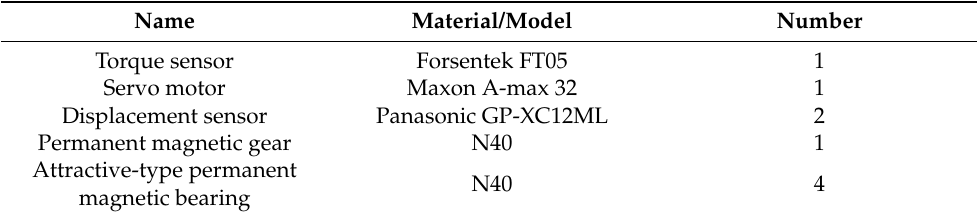
Figure 2. Physical structure of the noncontact torsion testing device: ( a ) Overall structure ( b ) Partial exploded view. Table 1. Specification of main components.